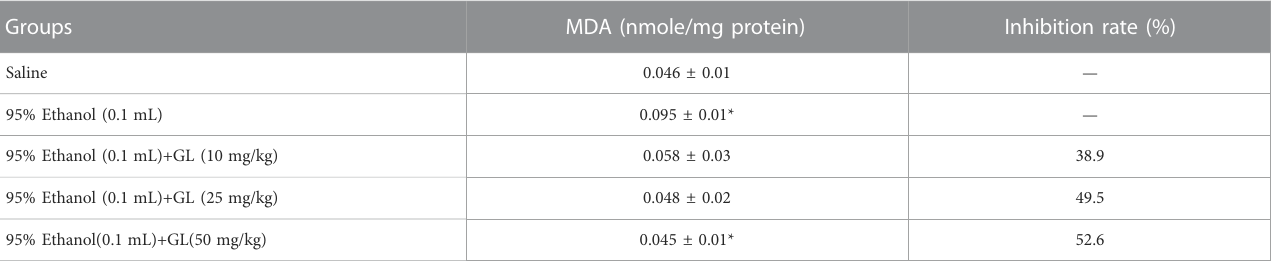
TABLE 4 Inhibitory effect of G. lucidum extracts (GL) on ethanol-induced lipid peroxidation in mouse liver homogenates. Groups